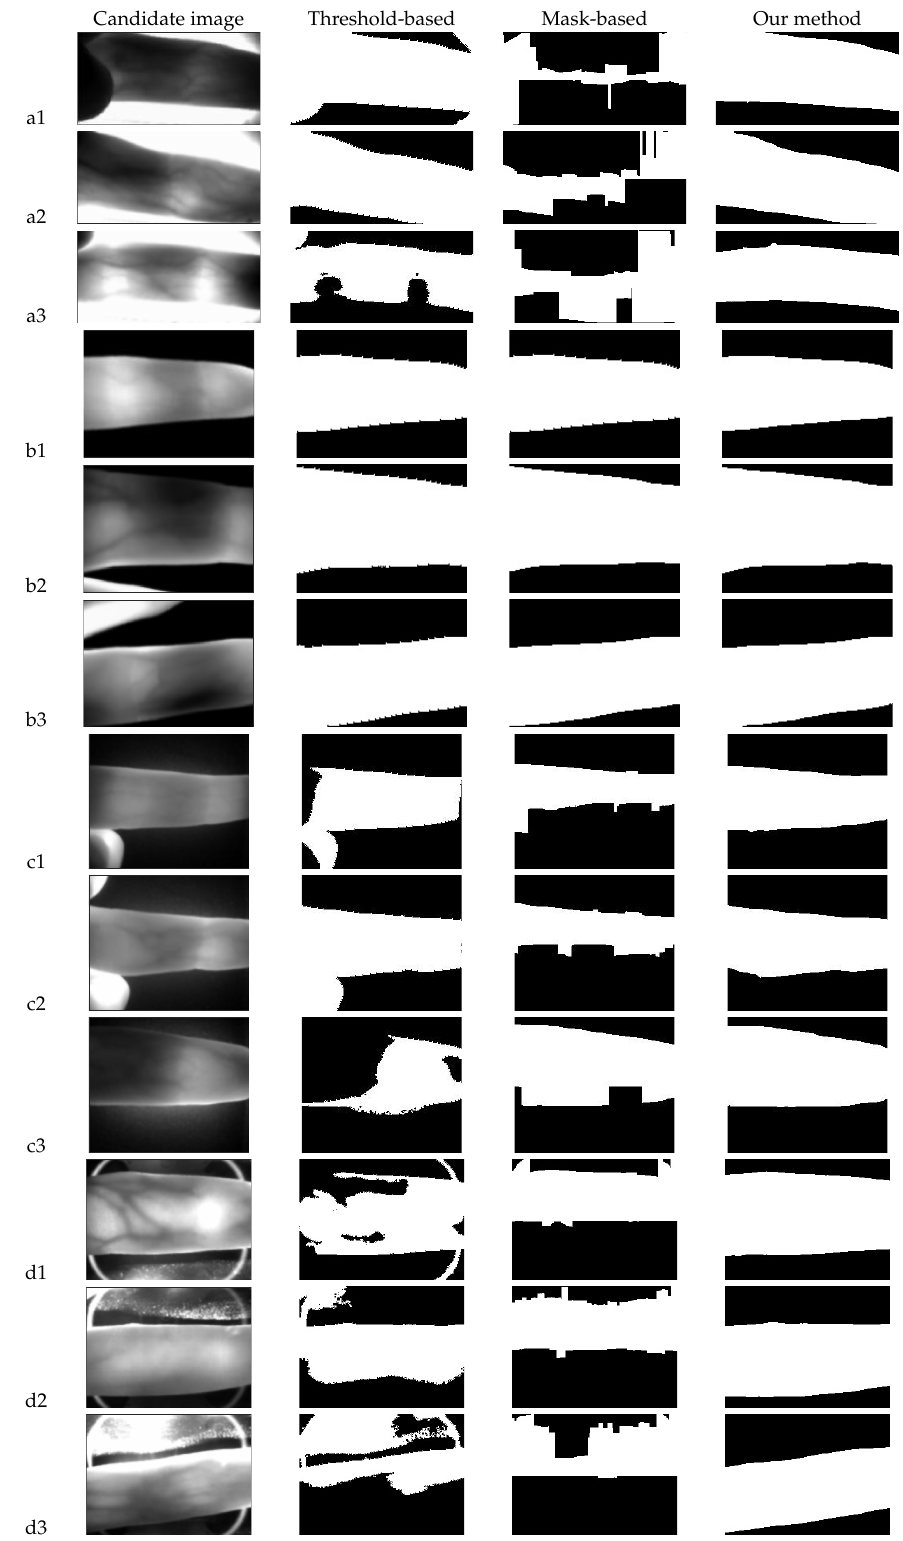
Figure 9. Comparison of the results of our proposed method with the threshold-based method and the mask-based method. ( a1 – a3 ) are the results from the HKPU dataset with good-, medium-, and poor-quality images. ( b1 – b3 ) are the results from the MMCBNU_6000 dataset with good-, medium-, and poor-quality images. ( c1 – c3 ) are the results from the FV-USM dataset with good-, medium-, and poor-quality images. ( d1 – d3 ) are the results from the ZSC-FV dataset with good-, medium-, and poor-quality